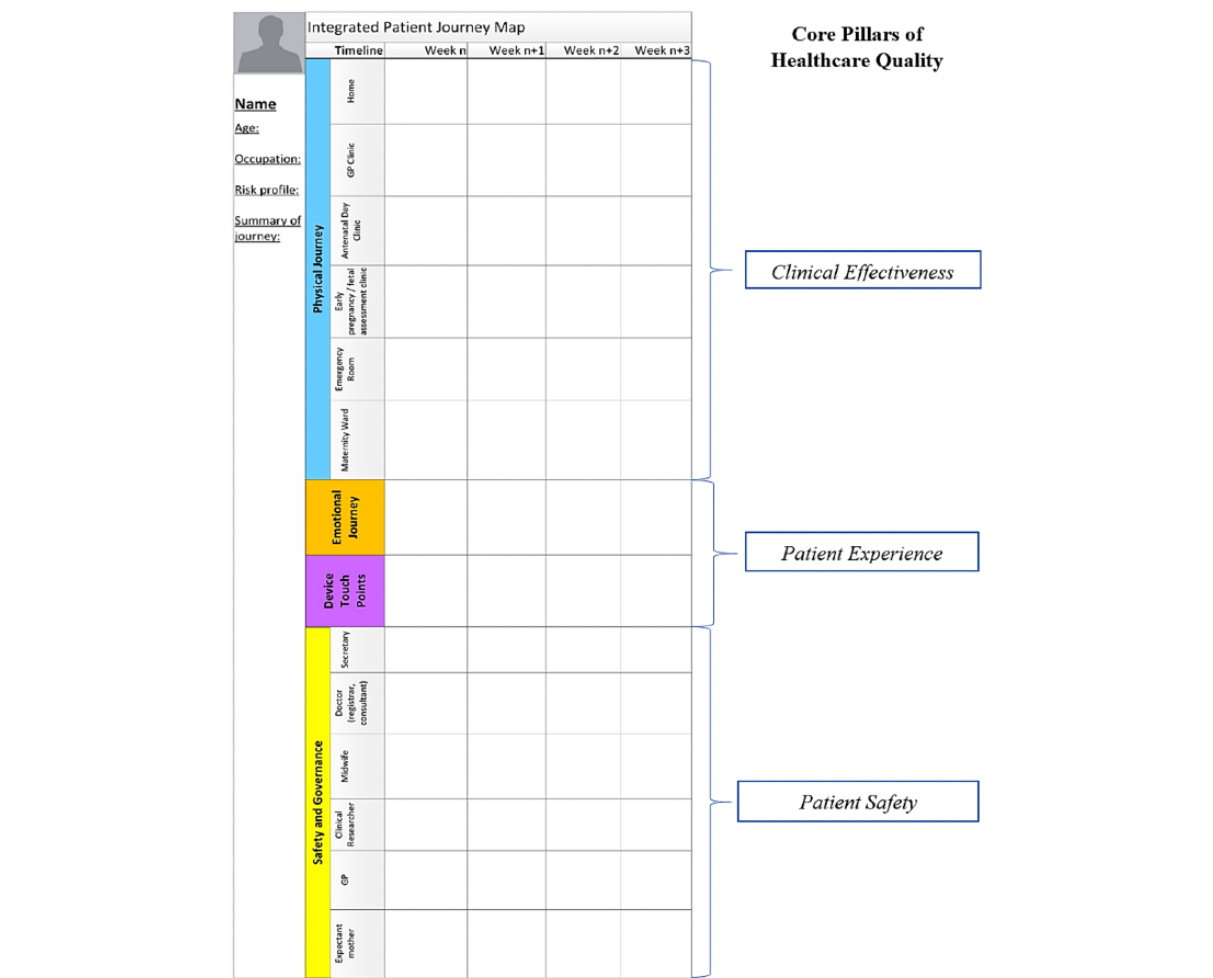
Figure 2. Base Integrated Patient Journey Map